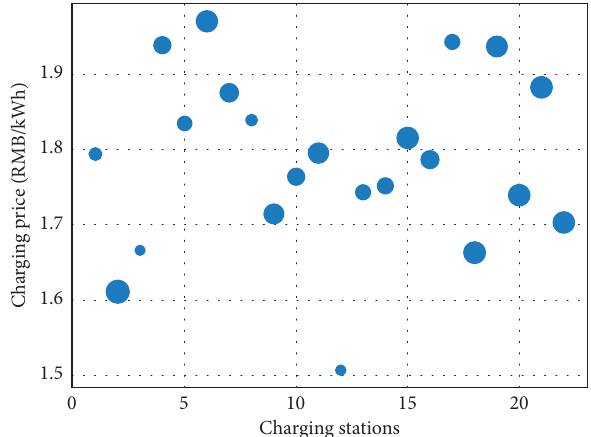
Figure 17: Charging price without optimization.